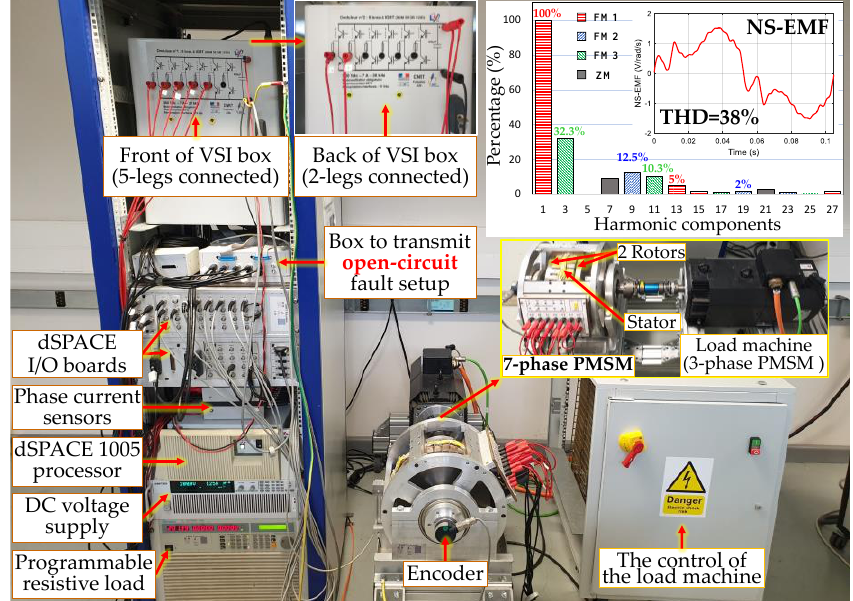
Figure 4. Experimental test bench and the multi-harmonic NS-EMF spectrum of the seven-phase PMSM to validate the proposed control scheme using Adaline_Fault and ECL strategy in faulty mode.